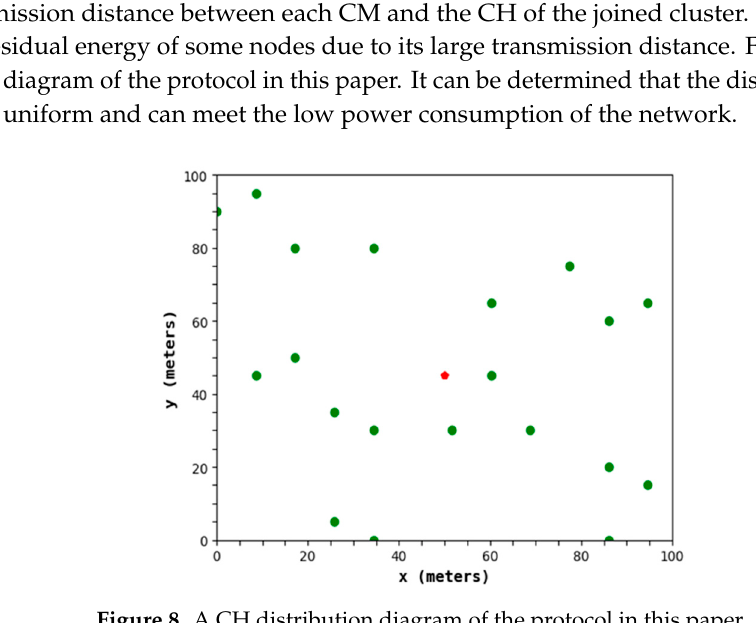
9 of 24 Figure 7. The three rounds of uneven CH distributions generated by the LEACH (Low-Energy Adaptive Cluster Hierarchical) protocol. In Figure 7, the green dot is the CH, and the red dot is the BS. It can be determined that in the process of CH selection, the LEACH protocol will generate a serious phenomenon of an uneven CH distribution, resulting in a relatively large distance between the CH and its member node, which